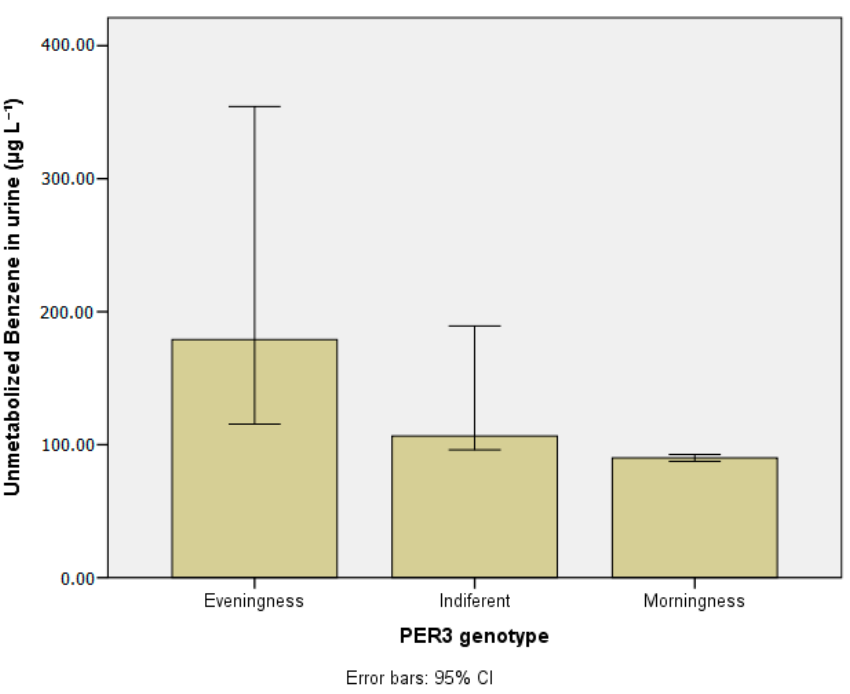
Figure 8. Unmetabolized benzene in urine ( µ g L − 1 ) according to PER3 gene VNTR polymorphisms. Table 7. Concentrations of unmetabolized benzene and toluene in urine ( μ g L − 1 ) according to PER3 gene VNTR polymorphism.